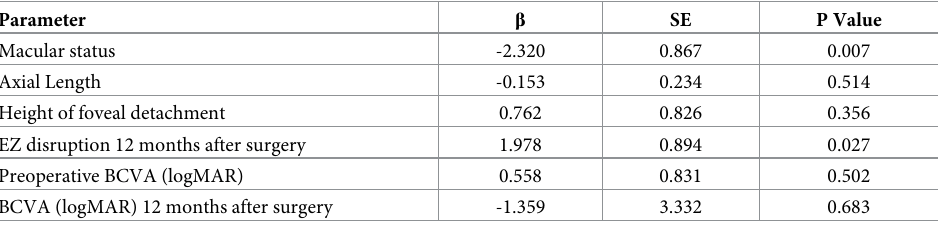
Table 3. Logistic regression analysis including the preoperative macular status as an independent